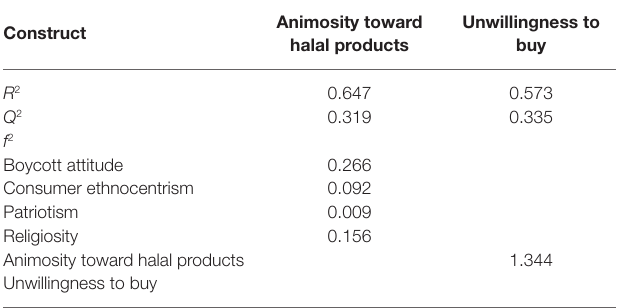
TABLE 3 | Coefficient of determination ( R 2 ), effect size ( f 2 ), and predictive analytics ( Q 2 ). Construct